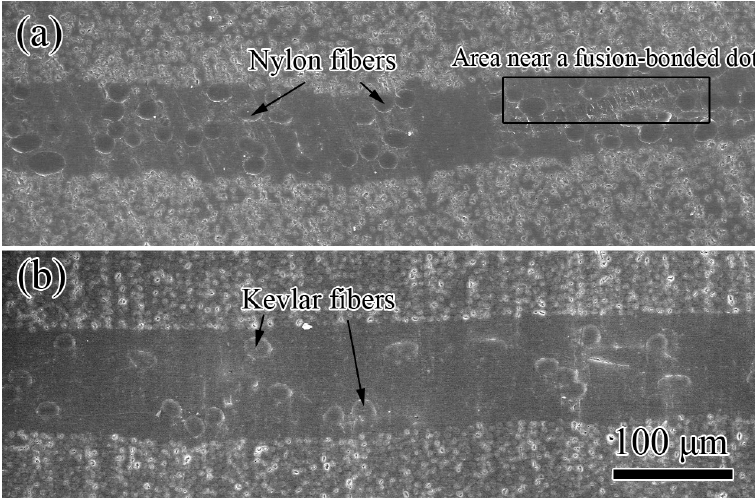
Figure 3. Cross sectional SEM images of the interleaved composites. ( a ) NVIC, ( b ) KVIC.